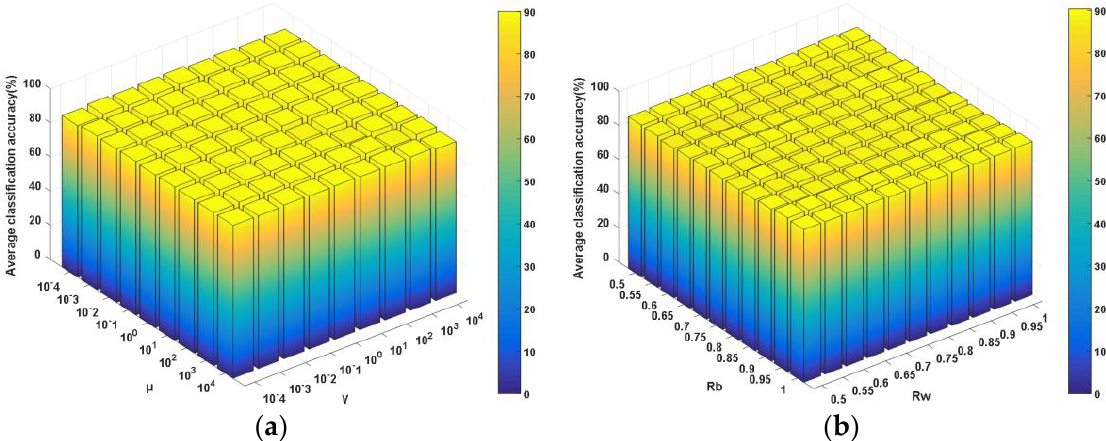
Figure 13. ELM plus NDCA performance under different combinations of parameters. ( a ) μ and γ ( best : 90.0894%; worst :